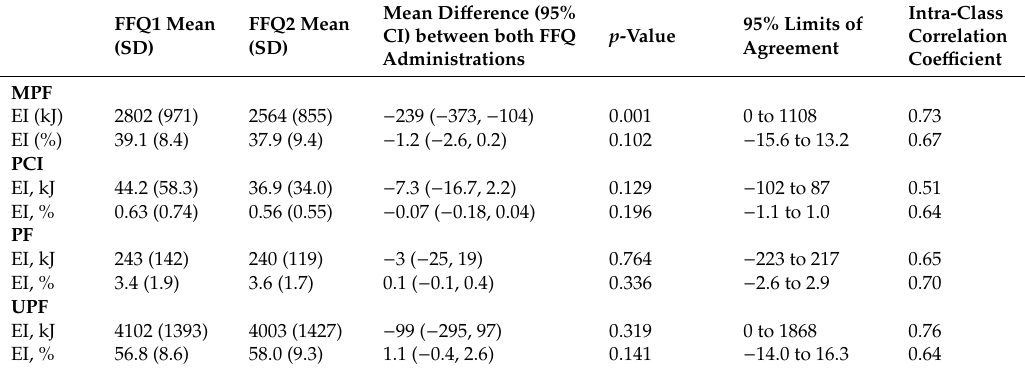
estimates from processed food categories between both FFQ administrations ( n =